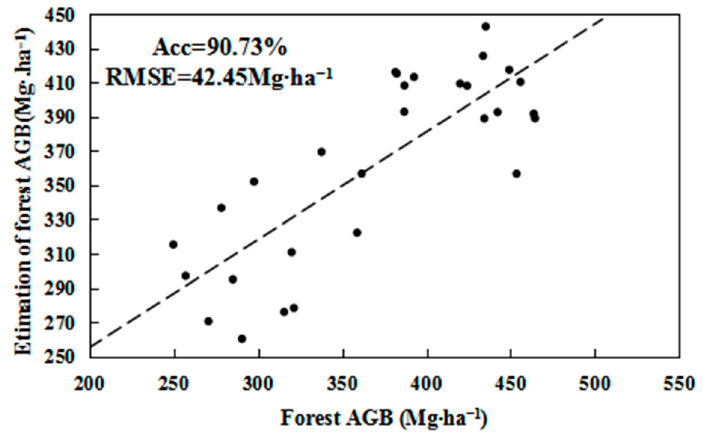
Figure 17. Scatter plot of ground observed with estimated forest AGB by the proposed multi-fea- tures-based model method.